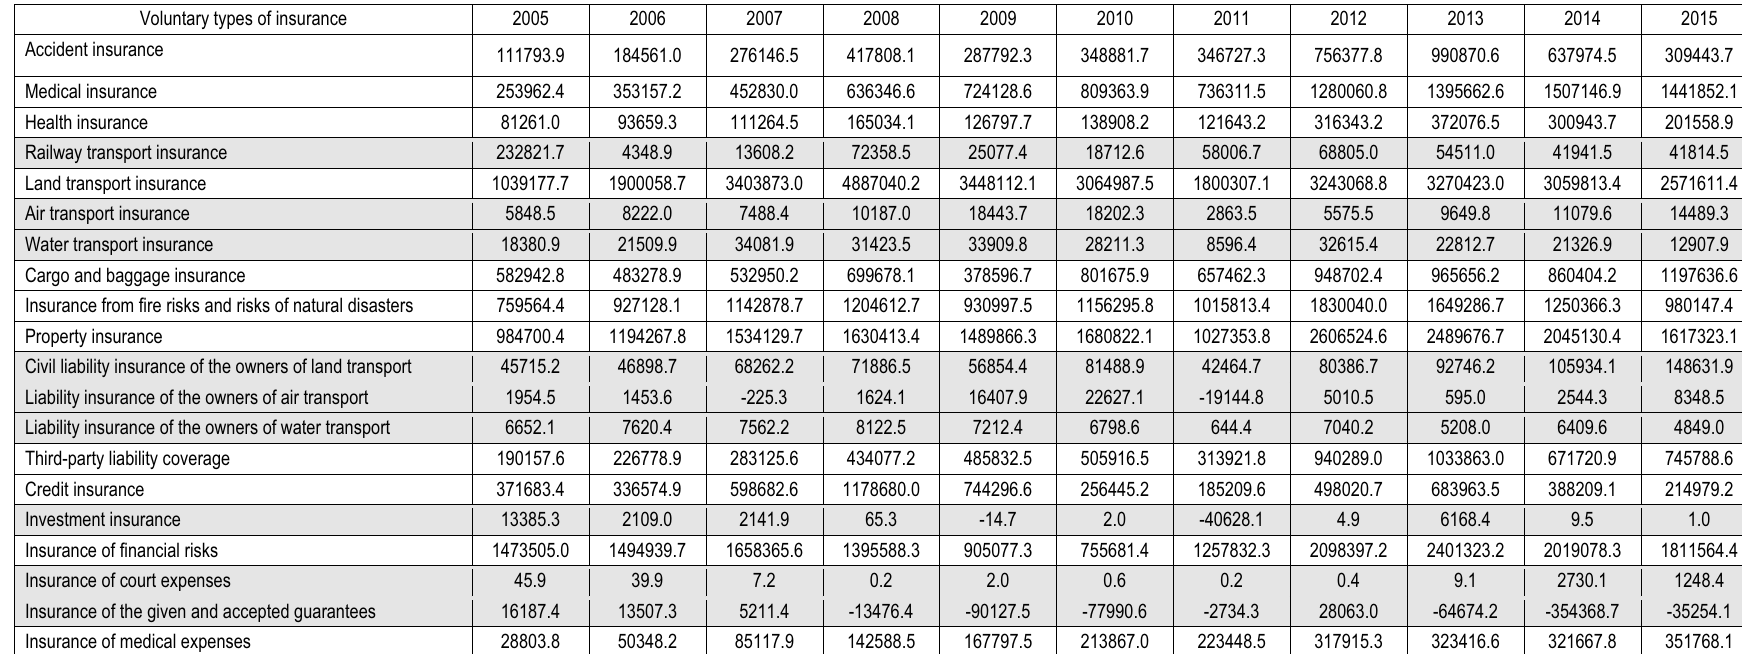
Table 1. Net income of insurance premiums for certain types of insurance in 2005-2015, thousand UAH